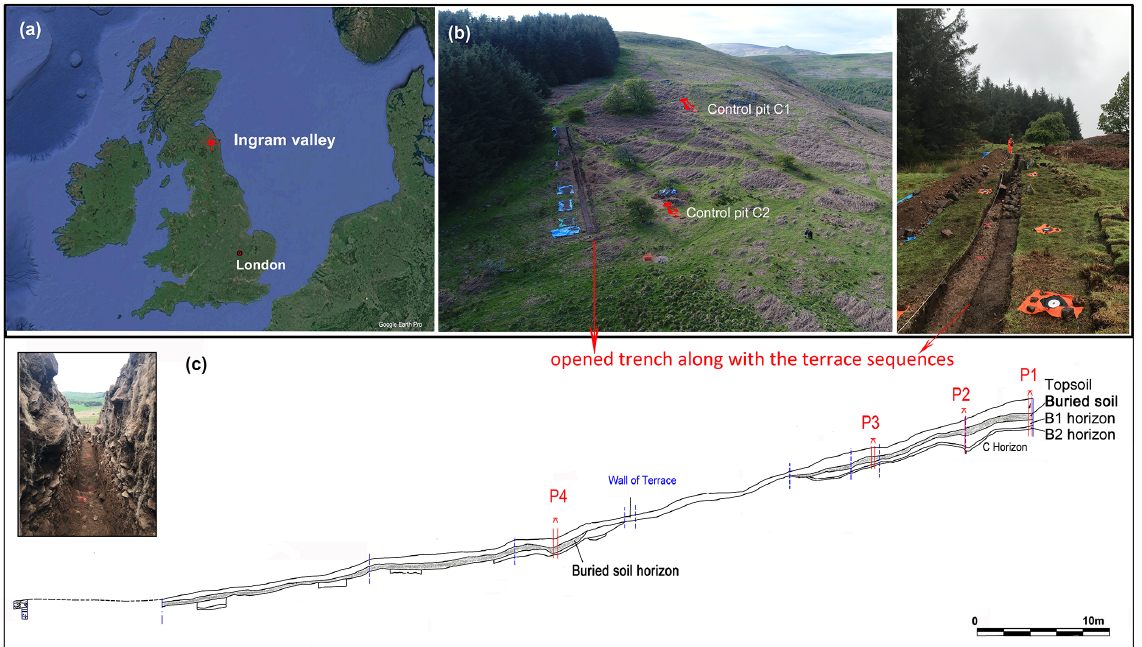
Figure 1. Map of (a) studying area (from ©Google Maps), (b) sampling site, and the (c) excavated terrace trench and sampling